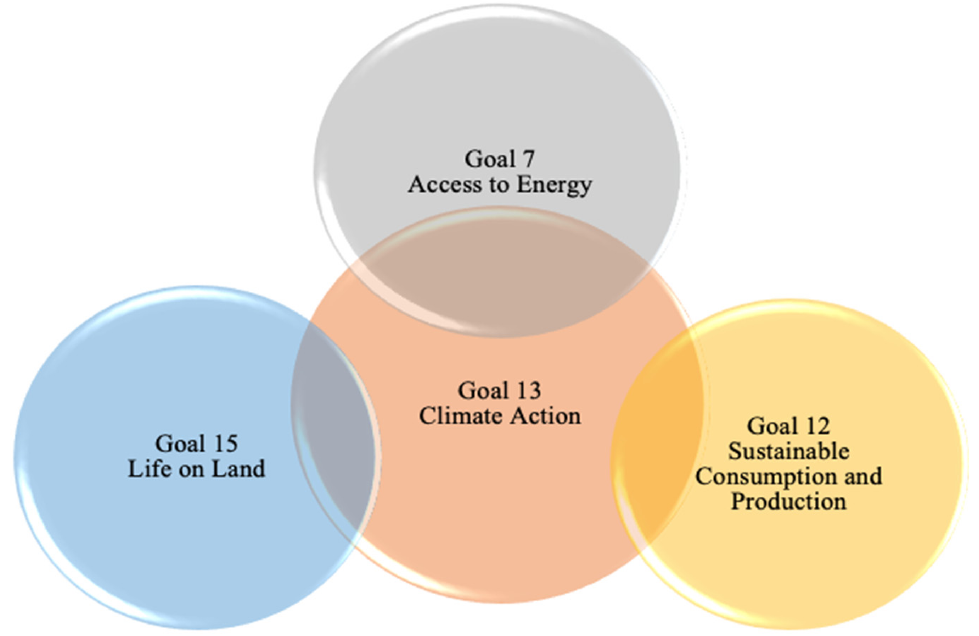
Figure 1. Examined SDGs 13 with SDG7, 12, and 15 separately.